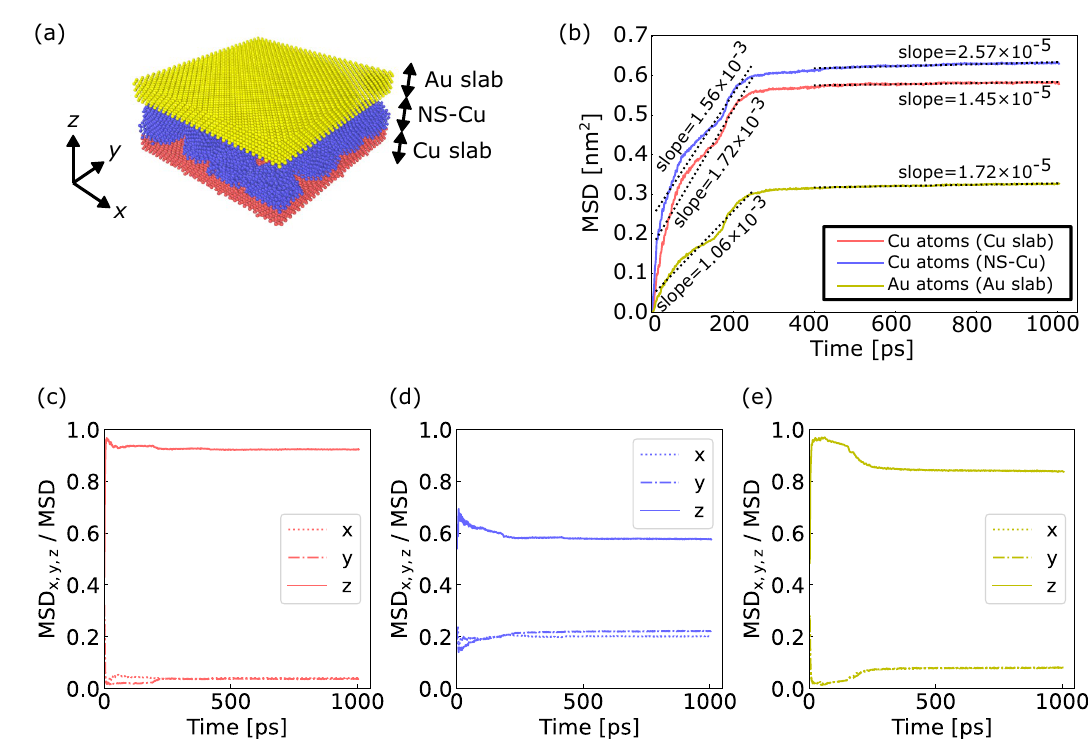
Figure 6. MSD evolution with time at S v = 2.8 nm −1 : ( a ) Number of atoms of the Cu slab, NS-Cu, and Au slab used in the MSD calculation was 11,027, 11,005, and 10,976, respectively. ( b ) The MSD evolution of each atom with linearly-fitted lines attached. MSDz to MSD ratio evolution of the atoms of the ( c ) Cu slab (red), ( d ) NS-Cu (blue), and ( e ) Au slab